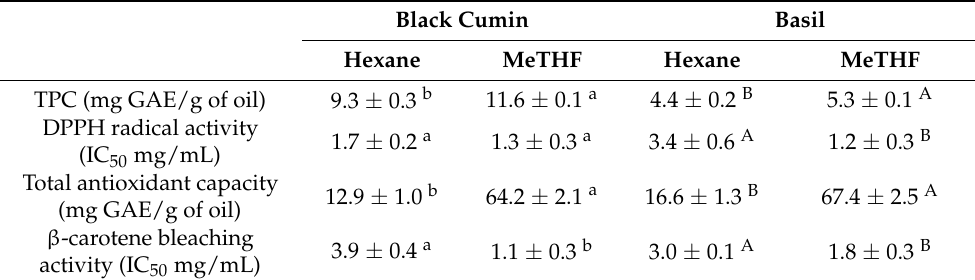
Table 4. Total polyphenols contents and radical scavenging capacity of black cumin and basil oils obtained with hexane and MeTHF extractions. Black Cumin